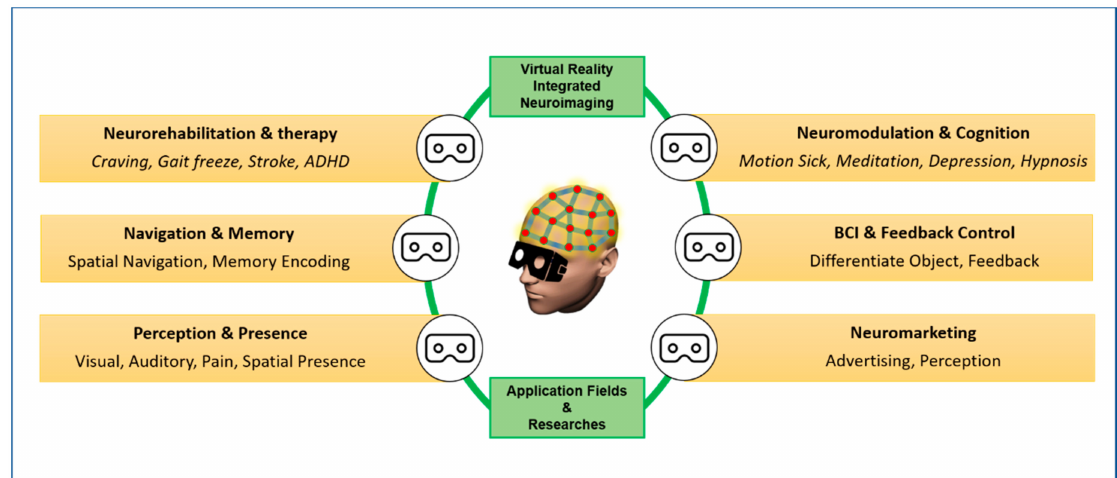
Figure 2. A brief overview of the applicability of VR integrated